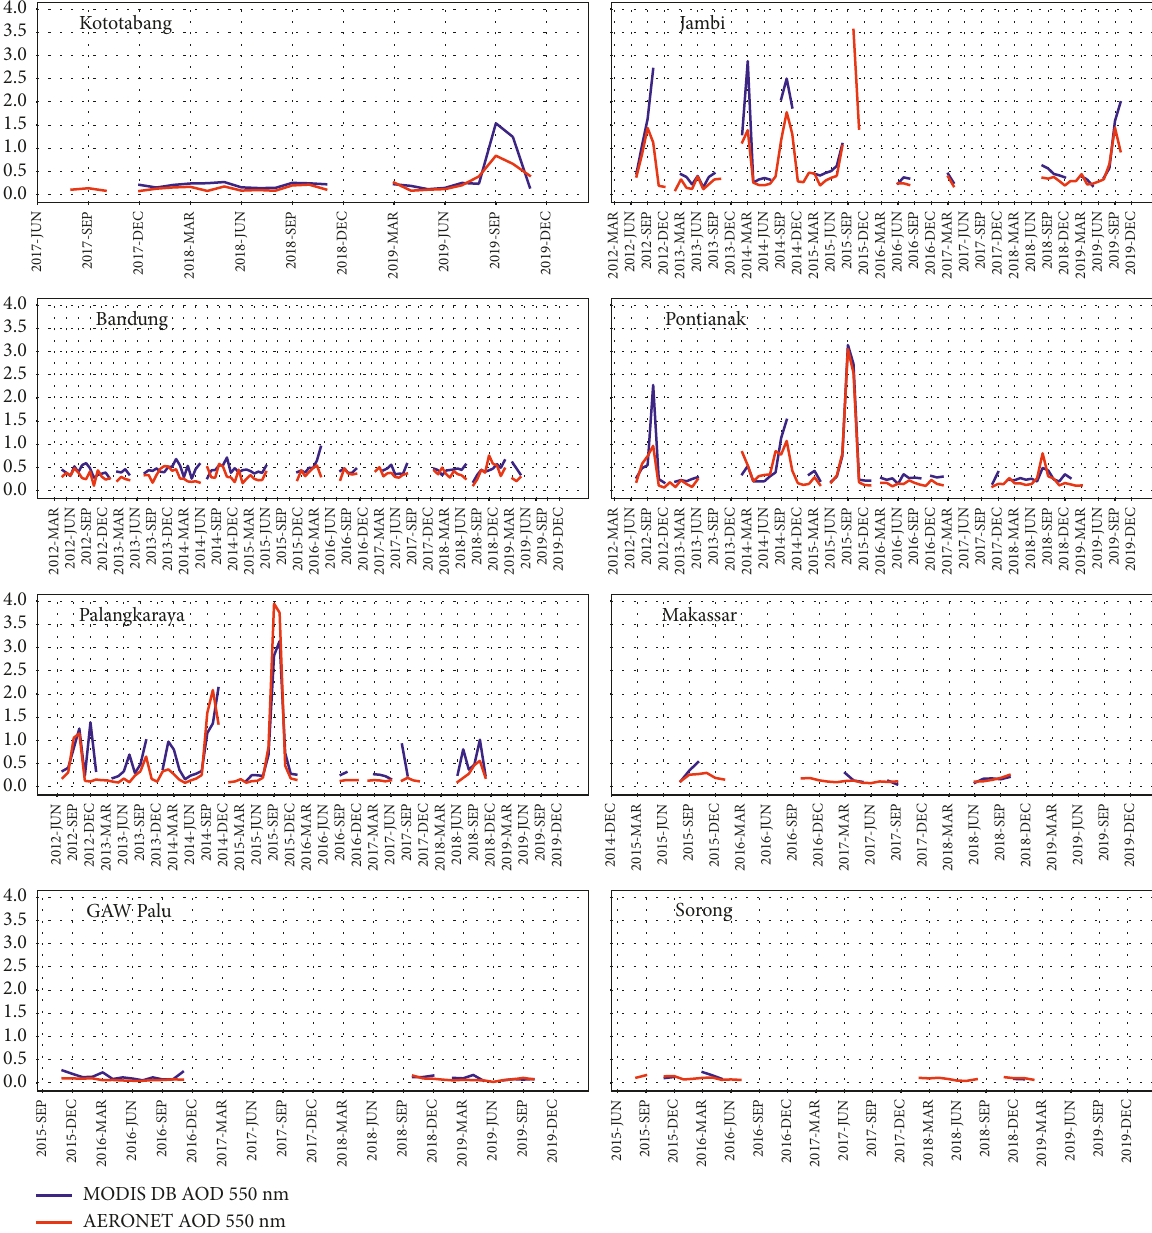
Figure 3: Time series plot of monthly MODIS DB AOD 550nm retrievals against AERONET AOD measurements at 550nm at AERONET sites over